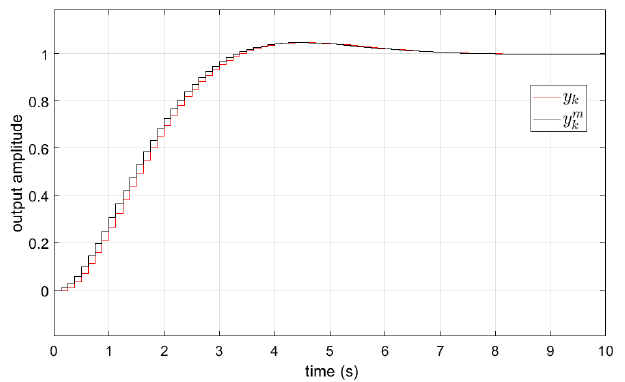
Figure 6. Unit reference input step response of the closed-loop with 2DOF controller, vs. the ORM unit step response.